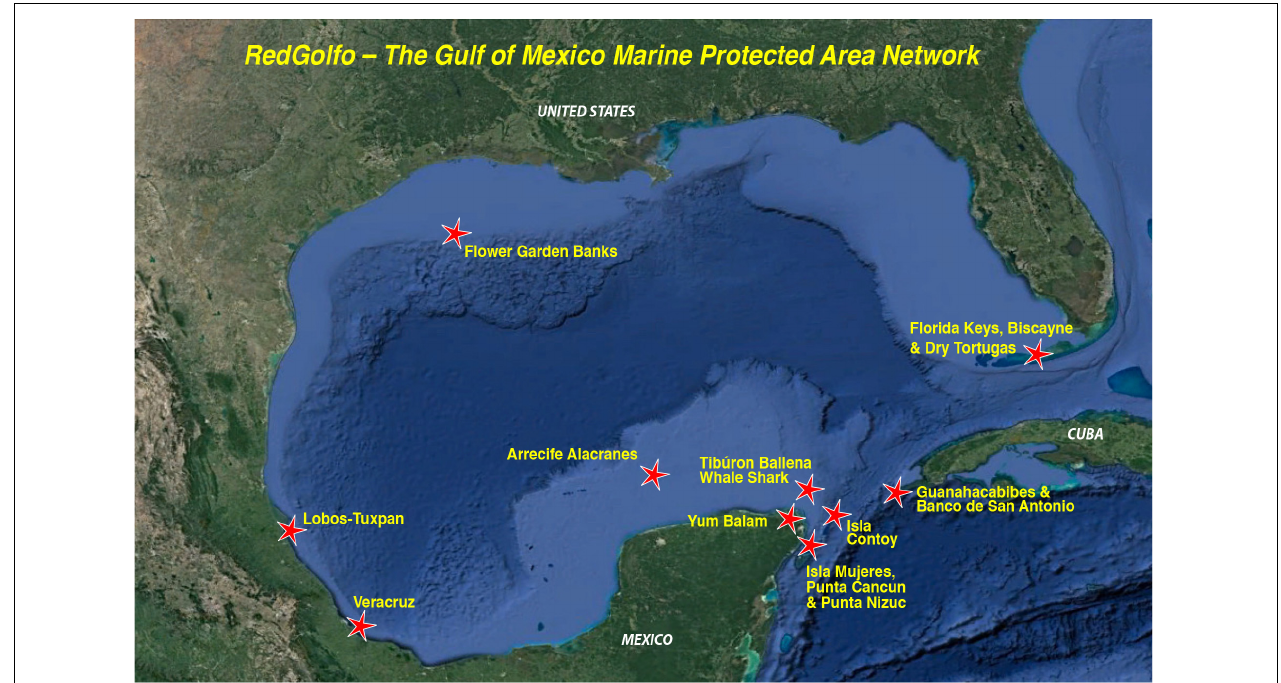
FIGURE 7 | RedGolfo, the Gulf of Mexico Marine Protected Area Network (Source: